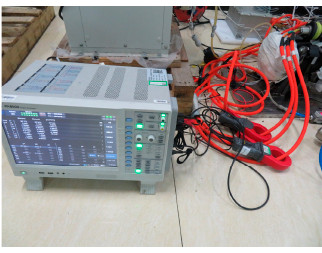
Figure 5. Experimental device diagram of air compressor motor.